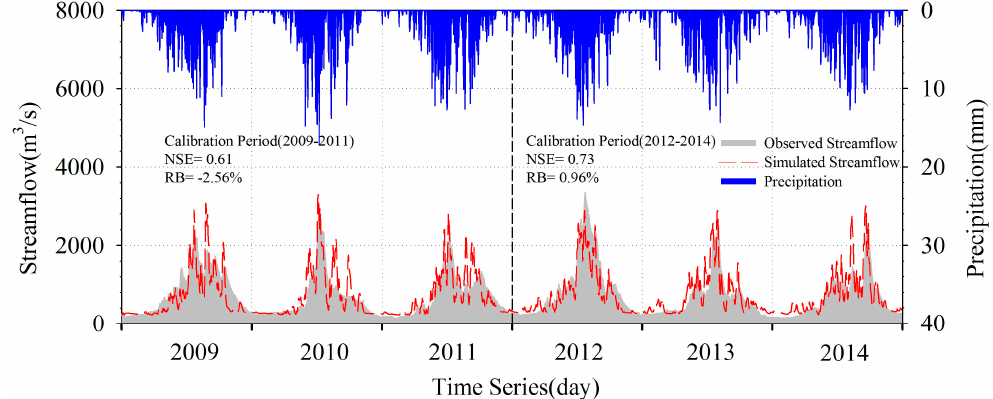
Figure 9. Observed and Variable Infiltration Capacity (VIC) model simulated streamflow with the CGDPA precipitation for the calibration period (2009–2011), and validation period (2012–2014) over the upper Yellow River basin.